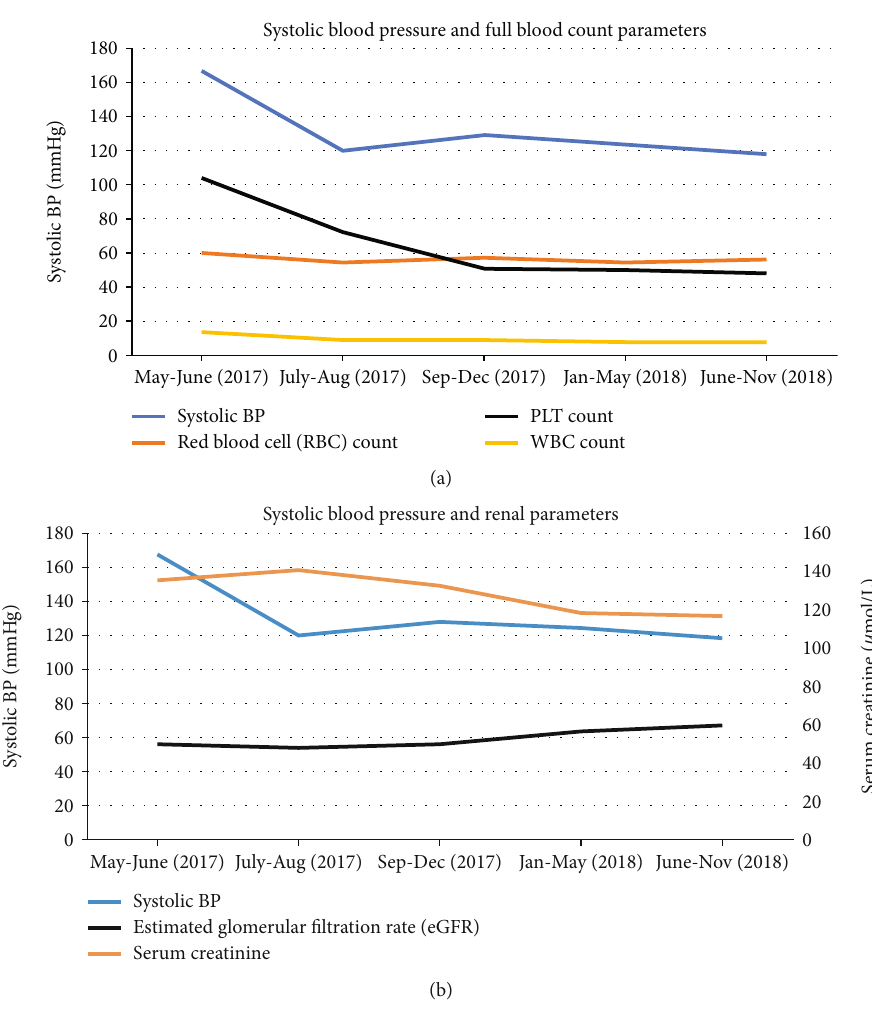
Figure 1: Case 1 — (a) CT renal angiogram showing right renal artery before angioplasty. (b) CT renal angiogram showing right renal artery after angioplasty.